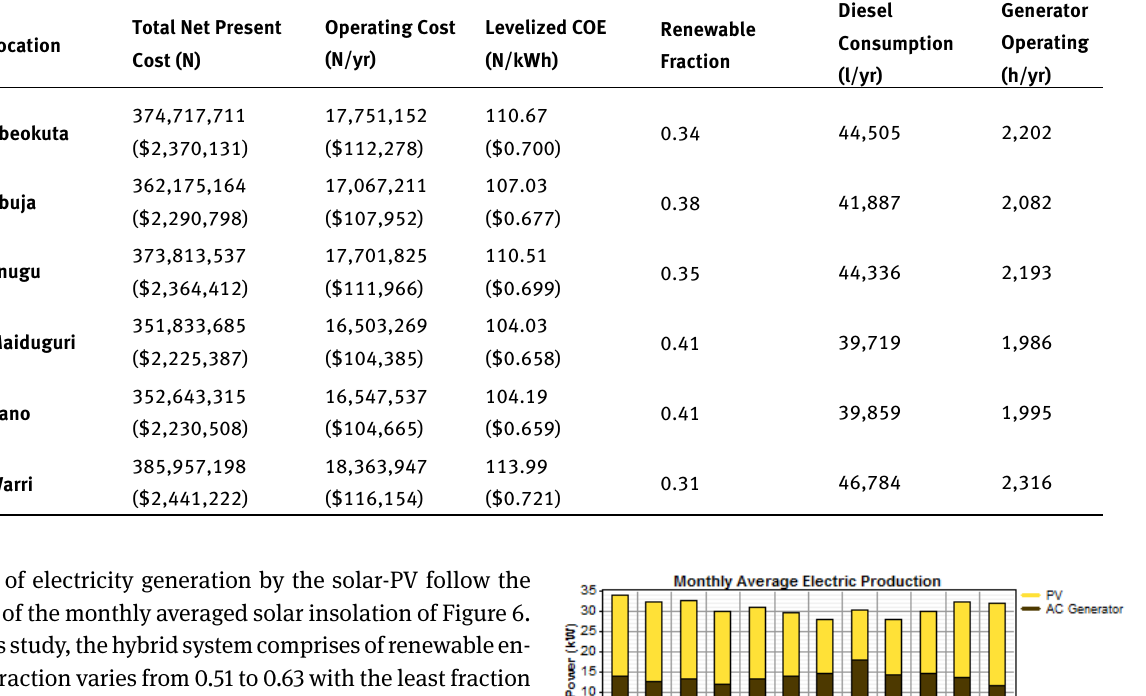
Table 4: Optimal System Configuration Results for all Locations Showing Cost in Naira (NGN)